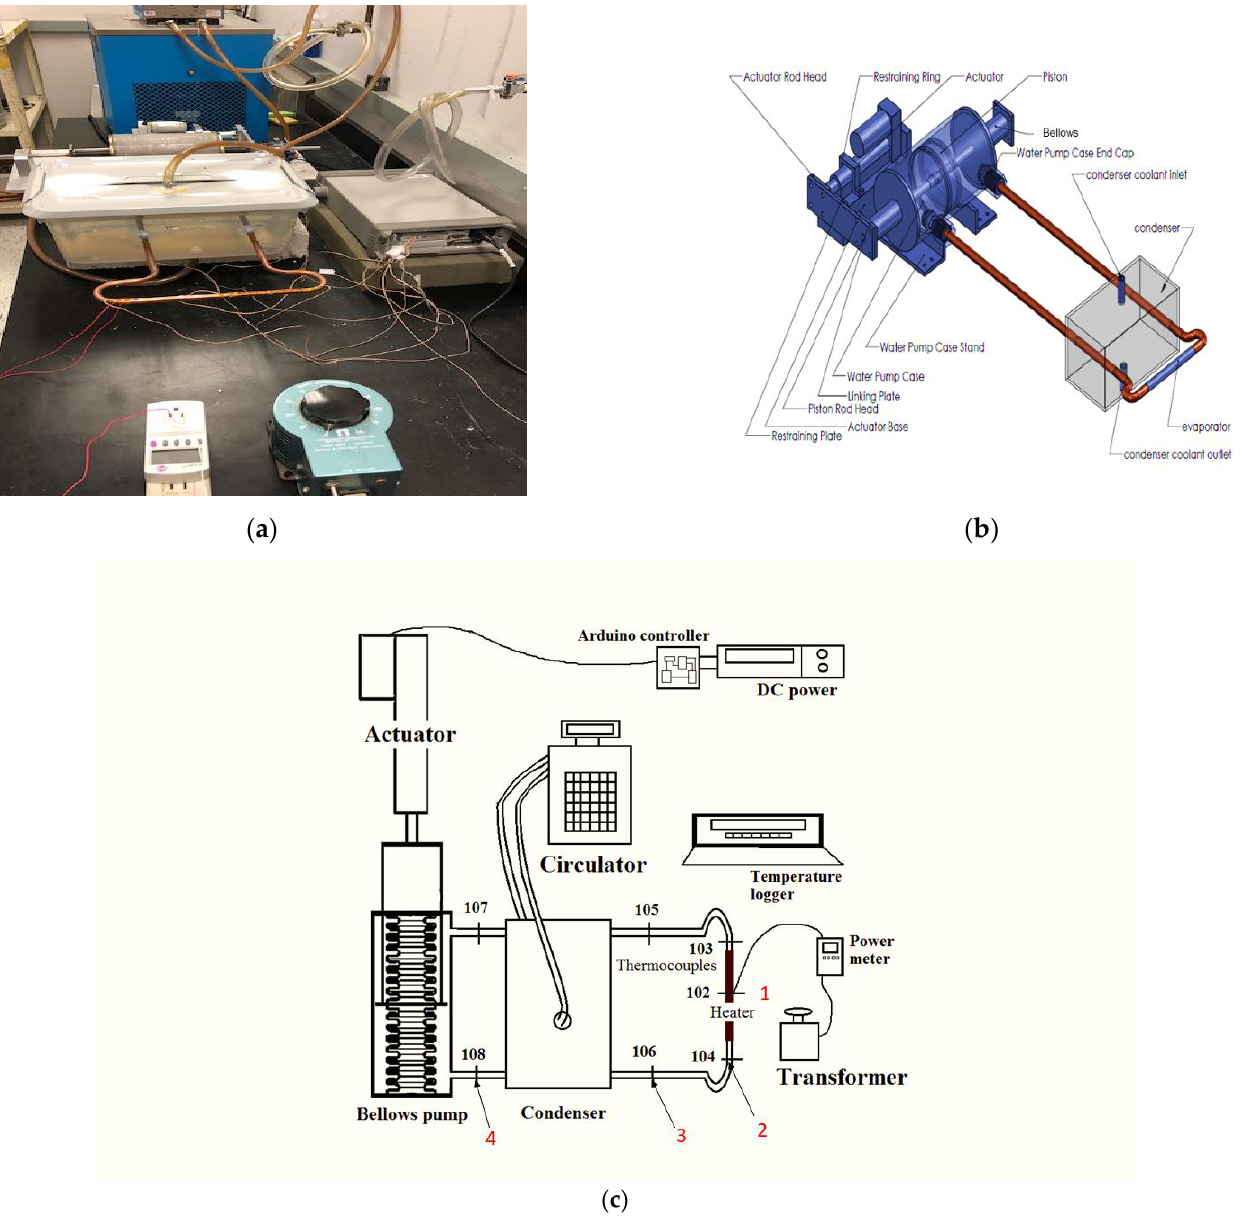
Figure 1. ( a ) Photo of the test rig assembly ( b ) schematic representation of the test rig assembly, and ( c ) location of the thermocouples with assigned positions 1, 2, 3, 4.